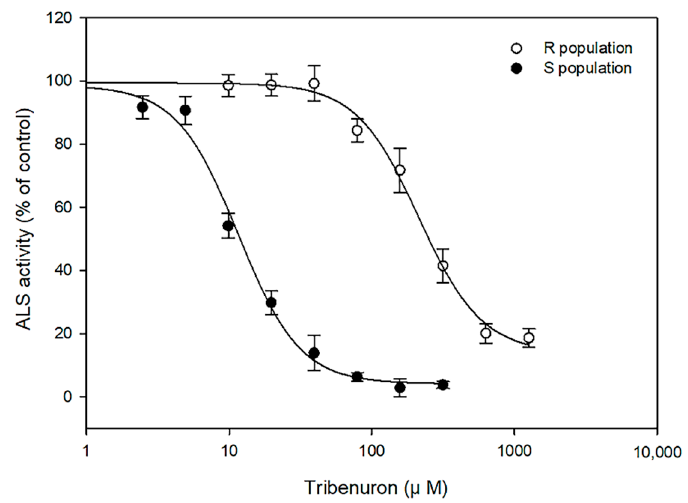
) and S( • ) populations of Silene (cid:35)